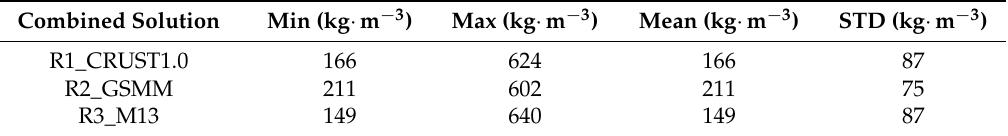
Table 2. Statistics of the Moho density contrast